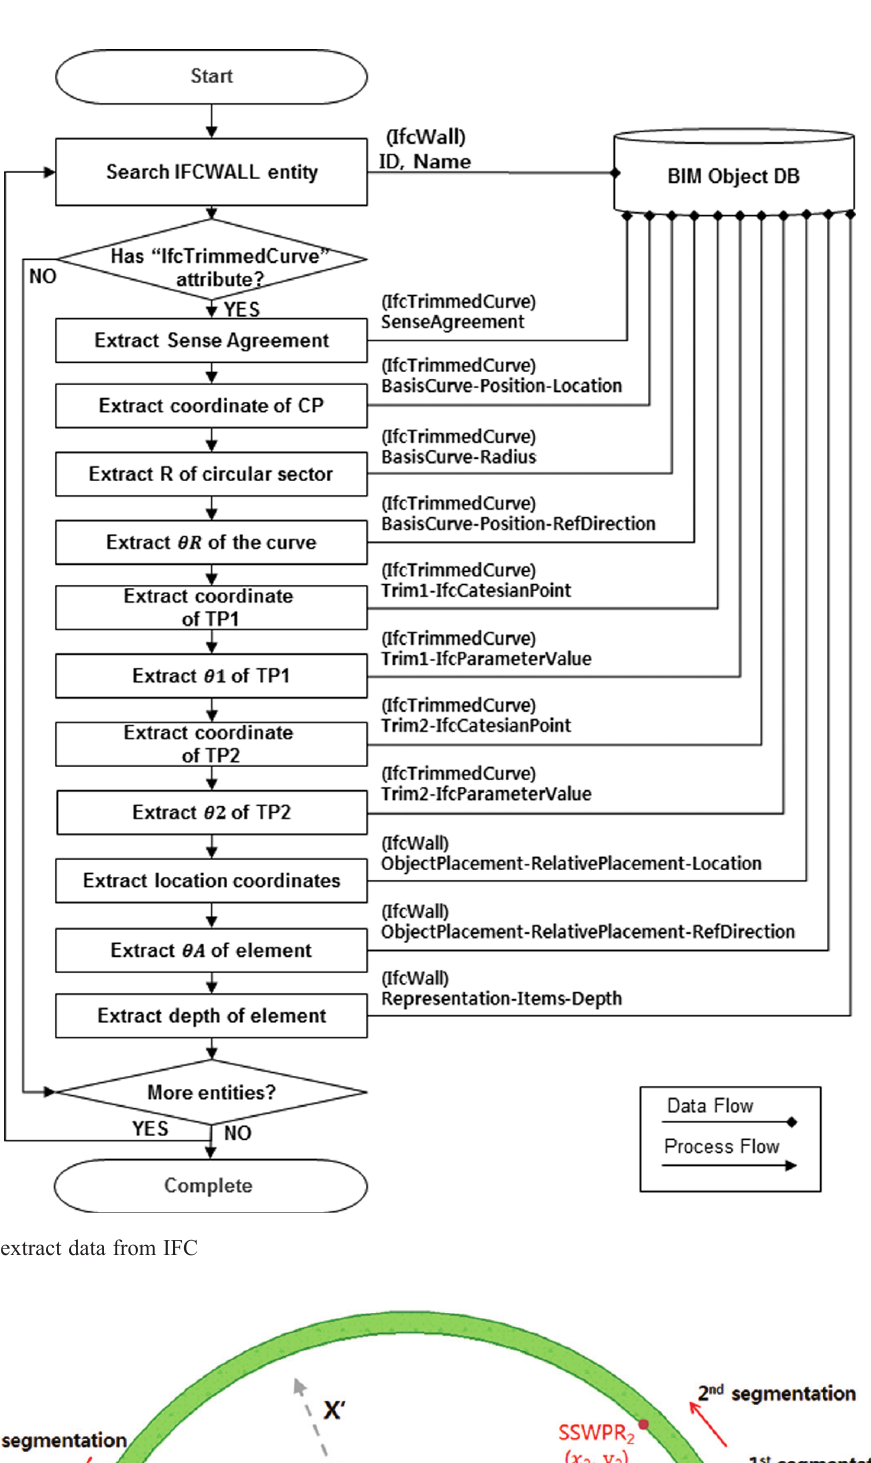
Fig. 4. Process to extract data from IFC